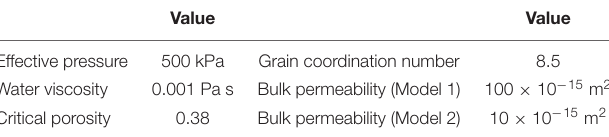
TABLE 2 | Other input